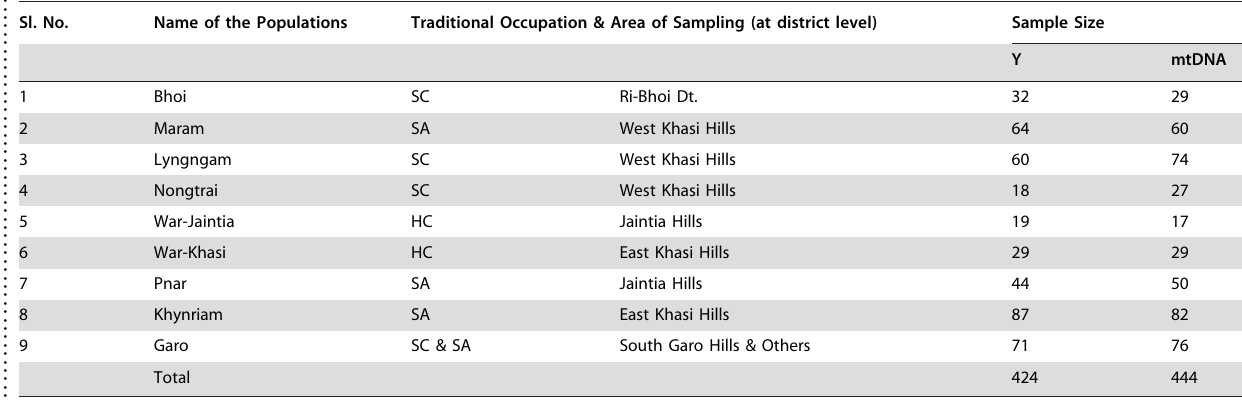
Table 1. Areas of sampling and the linguistic affiliations of the Meghalayan populations along with the number of samples typed for Y-chromosome and mtDNA. .. ... .... ... ... .... ... ... .... ... ... .... ... ... .... ... ... .... ... ... .... ... ... .... ... ... .... ... ... .... ... ... .... ... ... .... ... ... .... ... ... .... ... ... . Sl.